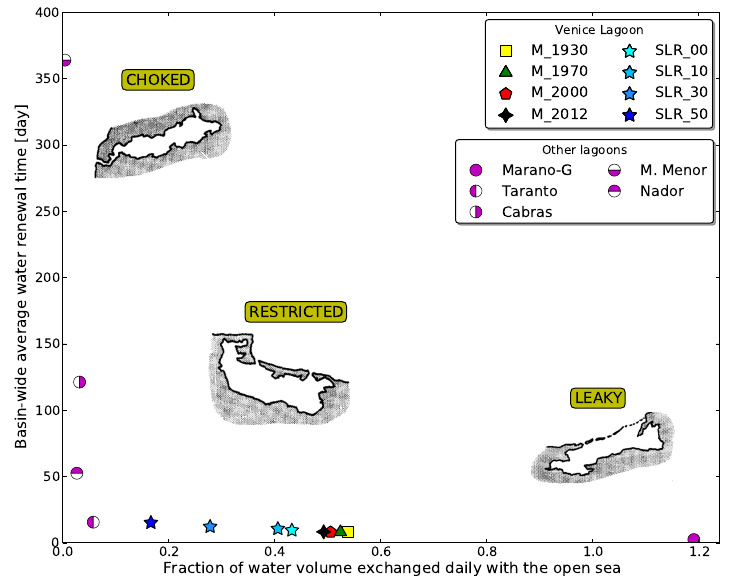
Fig. 8. Evolution of lagoon type, based on water exchange between lagoon and ocean and WRT, in the different scenarios under fall– winter conditions. Leaky, restricted and choked water body sketches are from Kjerfve and Magill (1989). Numerical results of five other Mediterranean lagoons are marked with filled and half-filled magenta